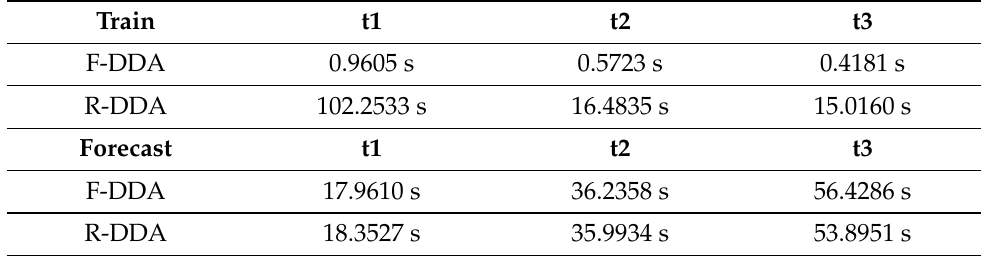
Figure 13. The simulation result of DDA on double integral system. The vertical dash-lines refer to the training windows. Table 1. The execution time cost for both F-DDA and R-DDA in every training and forecasting window when considering the model